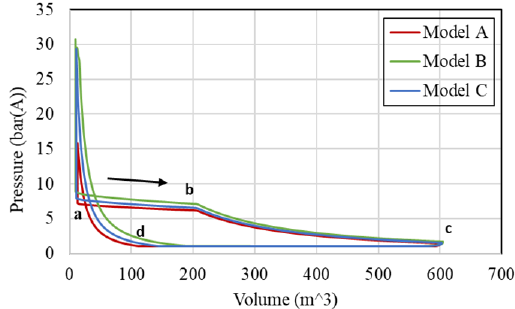
Figure 18. Comparison of pressure in expander of three models versus volume .